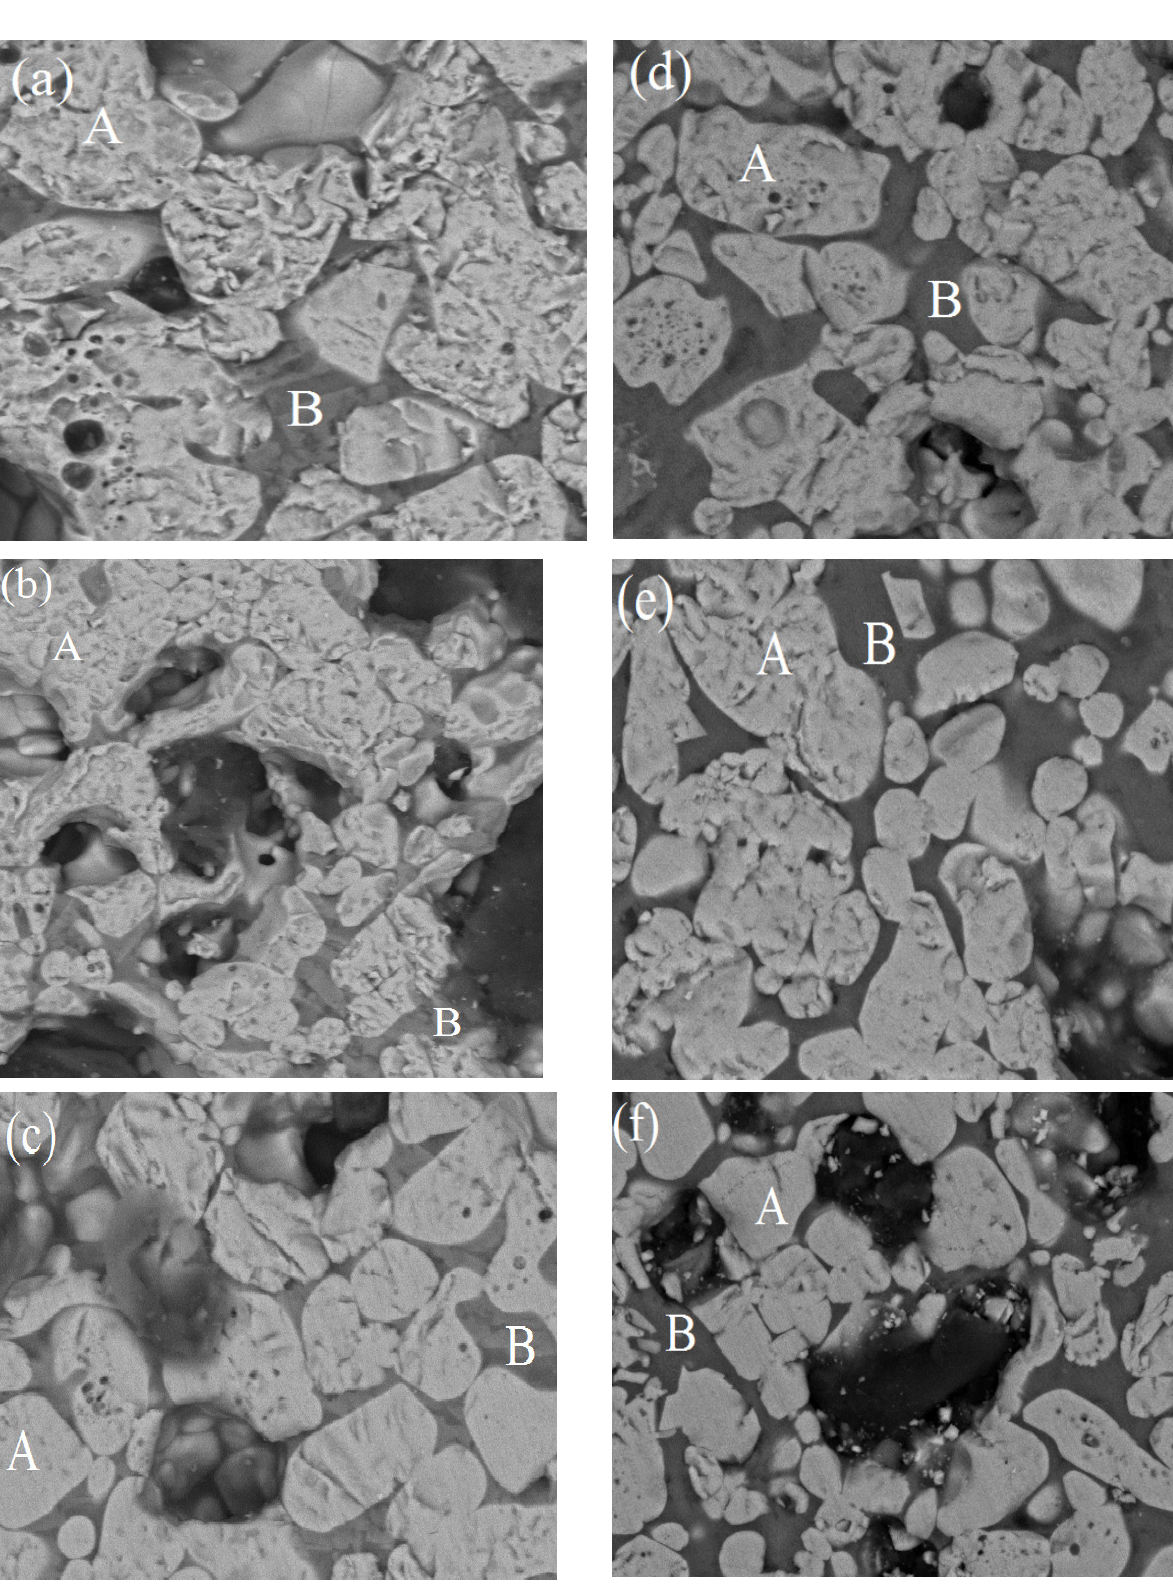
Figure 11. EDS images ( a – c ) K2A, K2B, K2C, ( d – f ) M2A, M2B, and M2C.